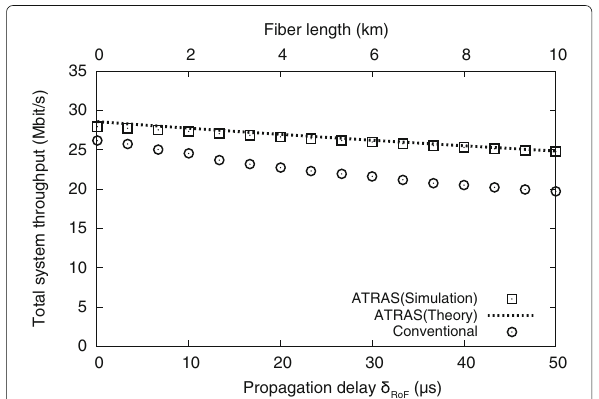
Fig. 7 Total system throughput vs. δ RoF with UDP bidirectional full buffer traffic when α = 1